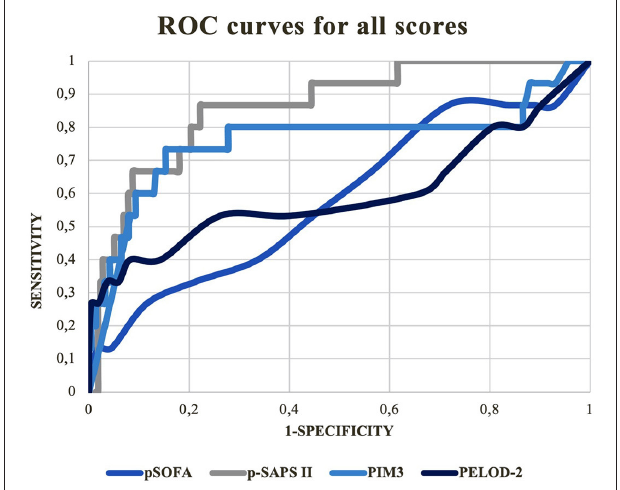
FIGURE 1 | ROC curves for the tested mortality